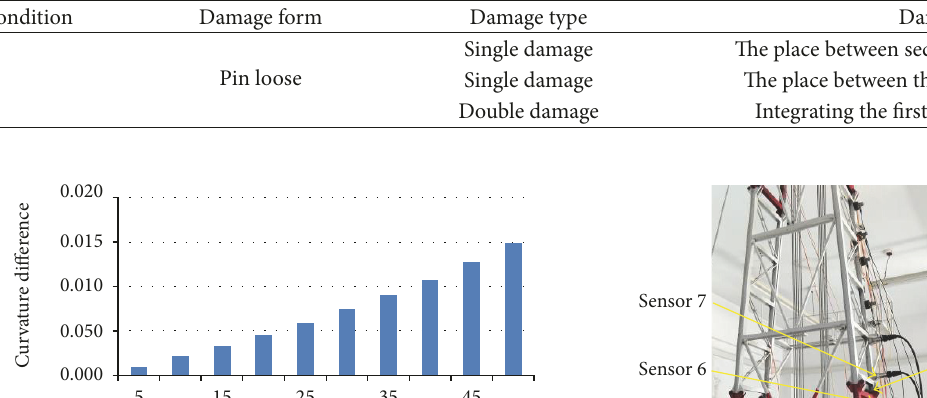
Table 2: Damage experimental conditions of the derrick steel structure.